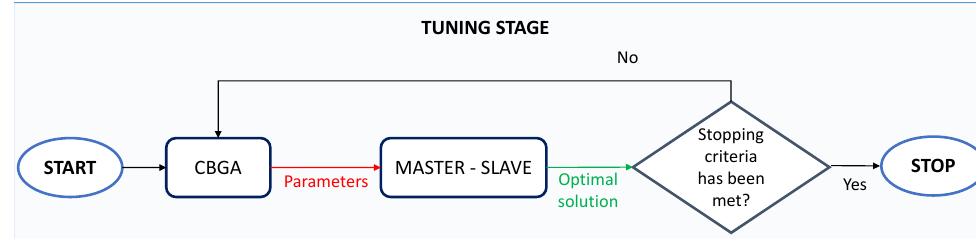
Figure 4. Operating principle of the tuning stage.